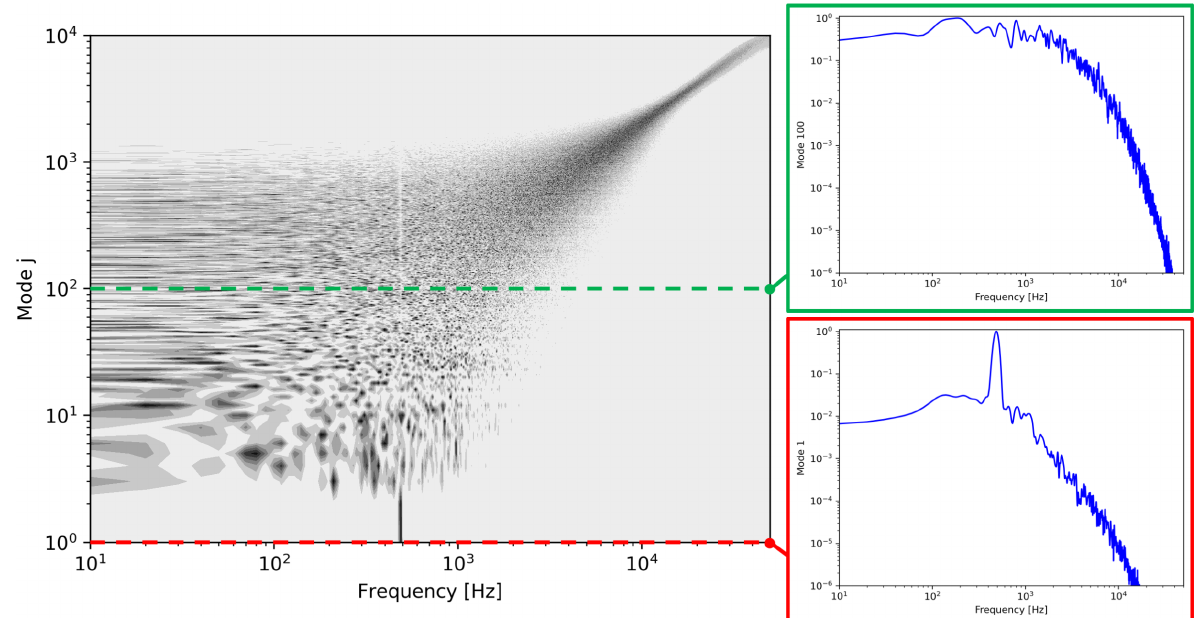
Figure 10. Contour of power spectral density of the POD temporal coefficients normalized by their respective maximum value of the power spectral density.